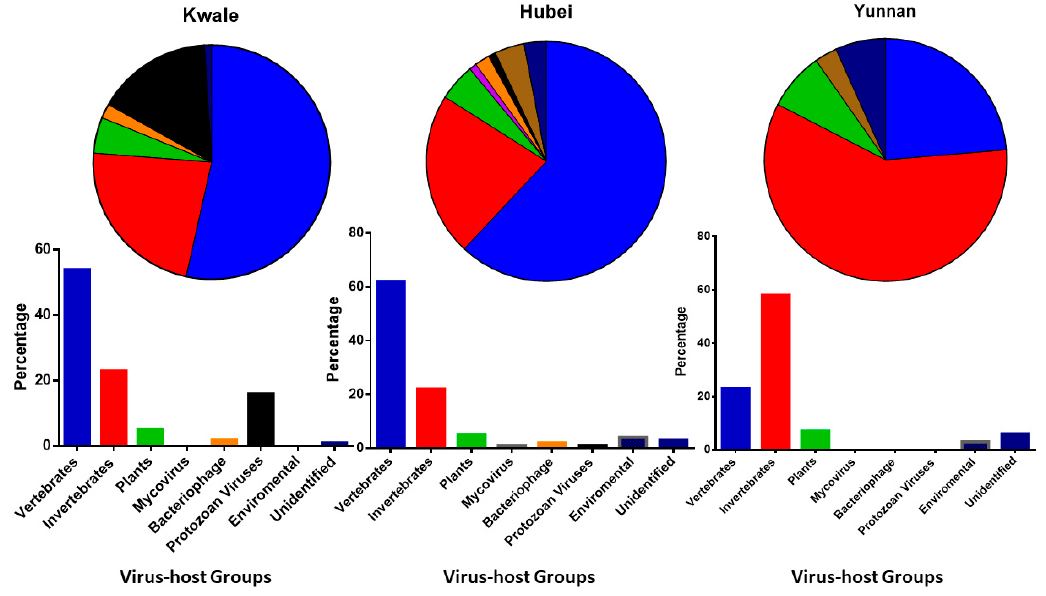
Figure 2. Percentage proportions of viruses in different host groups from mosquitos in Kwale, Kenya, and the Hubei and Yunnan provinces of China.